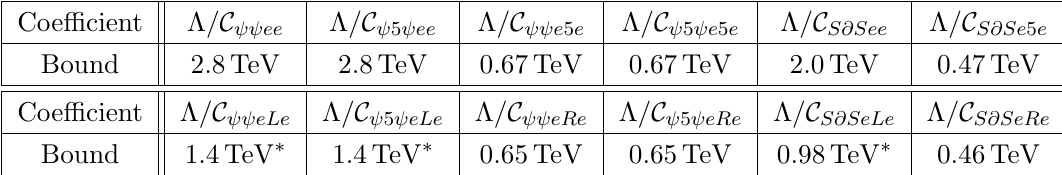
Table 2 . Lower 95% CL bounds on dimension 6 operators involving electrons from LEP-2. Bounds with are 99% CL, and all numbers are rather indicative, see text for details. (cid:3) Relic